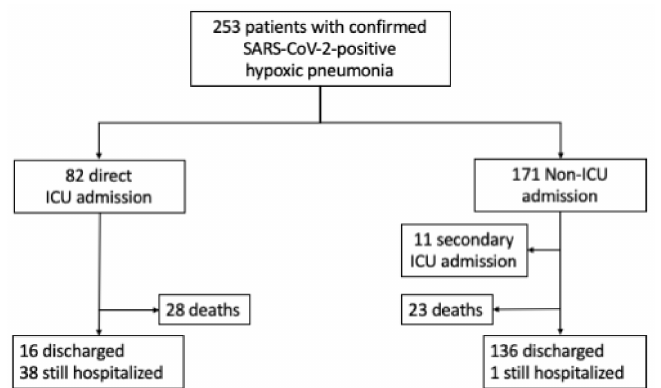
Figure 1. Flow diagram of patients with COVID-19 included in the study and outcomes during the 14-day follow